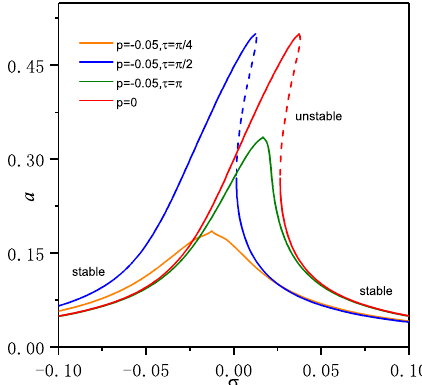
Figure 2. Frequency response curves showing the primary resonances response of the nonlinear beam with time delayed velocity